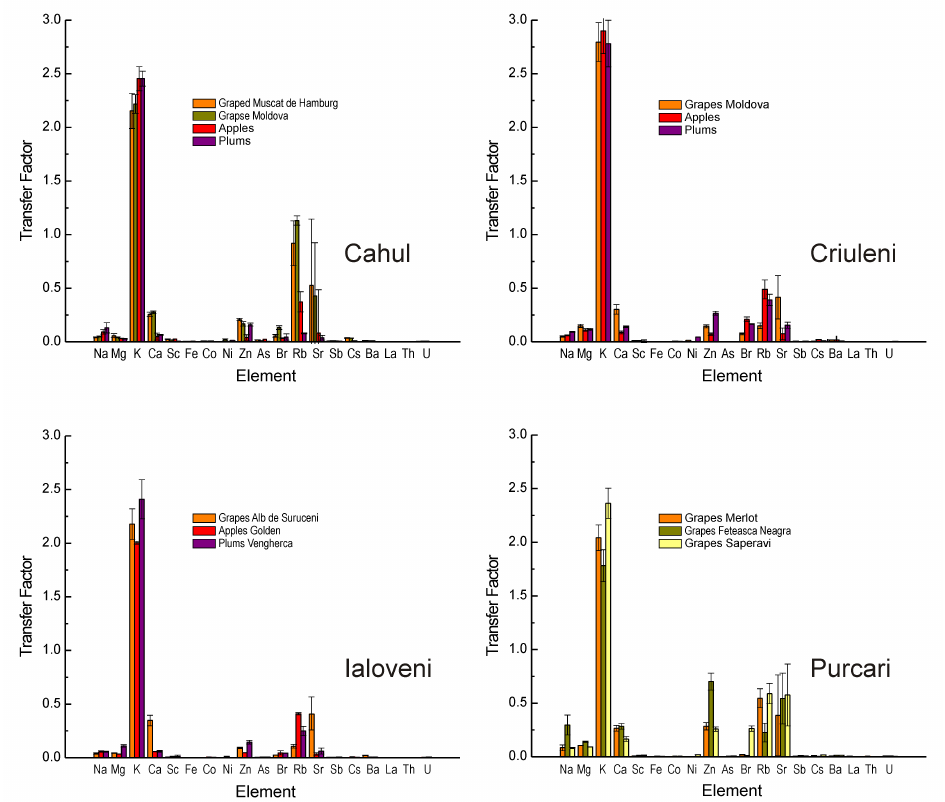
Figure 3. Transfer factor values in the system soil-fruit for fruits collected in four regions of the Republic of